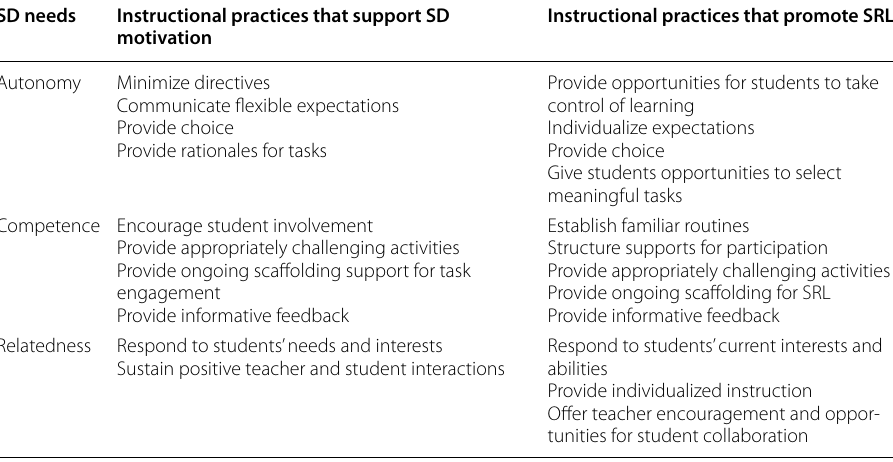
Table 2 Instructional practices that support learners’ SRL and self-determined motivation SD